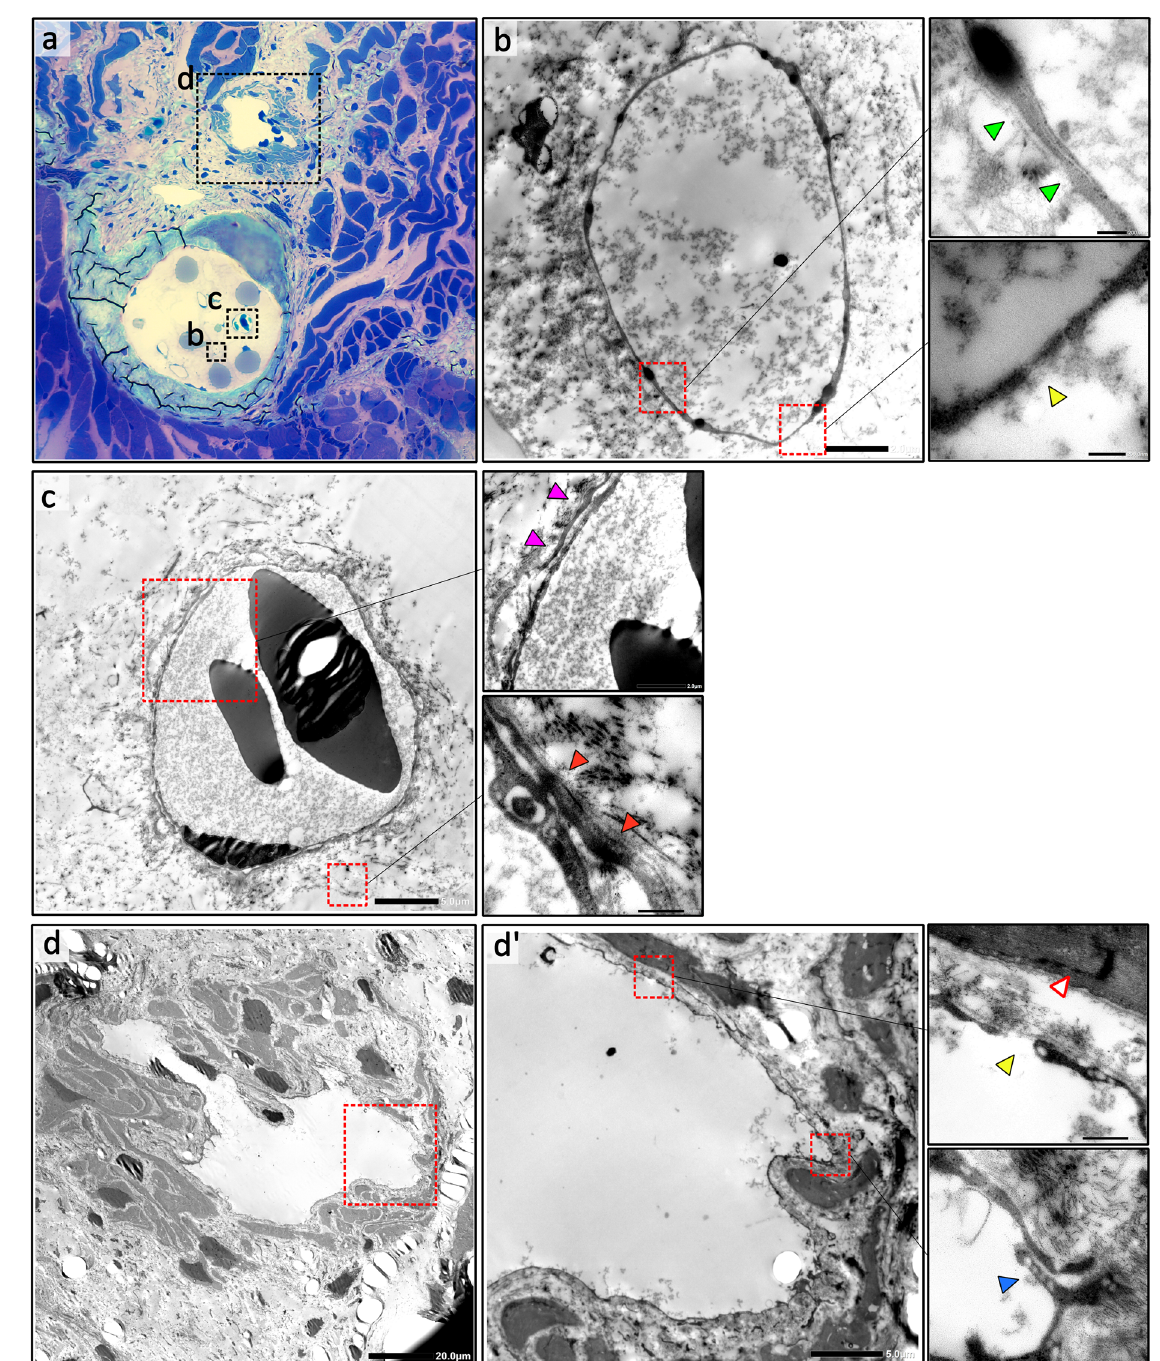
Figure 4. Ultra-structure of the intraosseous lymphatics and veins and the lymphatic heart. ( a ) Resin embedded toluidine blue stained scanning section of a newt abdominal rib showing the transverse vertebral intraosseous lymphatics (TvIL) ( b ) and the transverse vertebral intraosseous veins (TvIV) ( c ) inside the bone marrow, and the adjacent lymphatic heart (LH) ( d ). Transmission Electron Microscopy confirmed the TvIL (( b ) Scale bar = 2 μm) and LH (( d ) Scale bar = 20 μm) were lined by lymphatic endothelial cells (LEC) with the characteristic ultra-structural features of lymphatic endothelium including absence of pericytes, thin walls and highly attenuated LEC cytoplasm (green arrowheads ( b )), with sparse tight junctions, few adherens junctions, occasional spaces between LECs (yellow arrowheads ( b and d’ )) and overlapping leaf-like endothelial cell junctions (blue arrowhead ( d’ )). The specialized LH muscle had characteristic features of both cardiac and skeletal muscle (white arrowhead ( d’ )). In contrast, the TvIV (( c ) Scale bar = 5 μm) were lined by blood endothelial cells (BEC) had thicker walls, surrounded by pericytes (magenta arrowheads ( c )) with several tight junctions and adherens junctions (red arrowheads ( c )) and had multiple cytoplasm vesicles. Red blood cells were also seen in blood